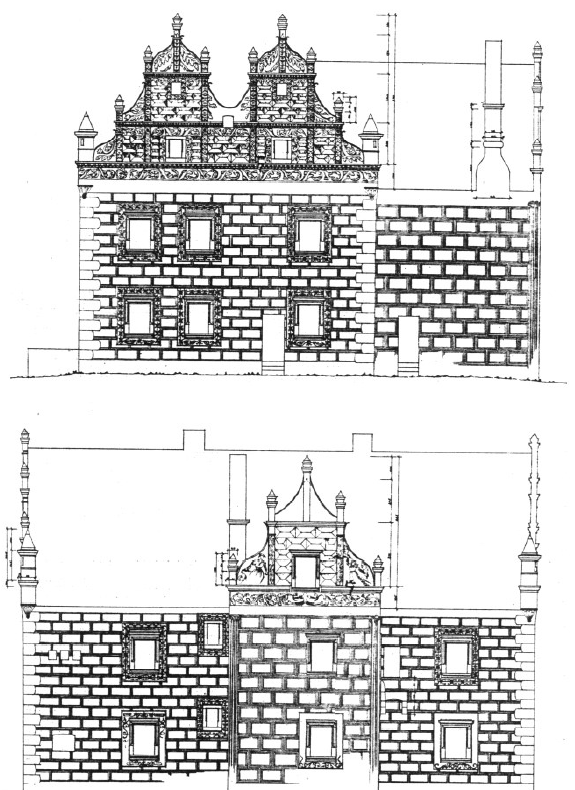
Figure 17. A drawing inventory of two facades of the manor house in Gorzanów-Raczyn. Source: Grundmann (1982, vol. 2, p. 88).